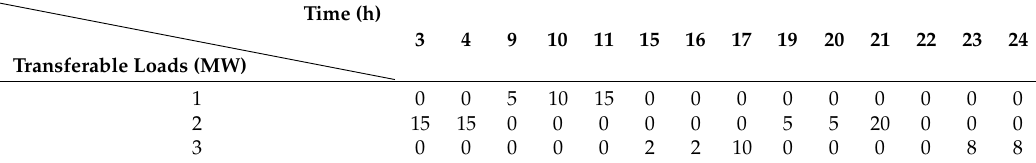
Figure 4. Load curve after dispatch. Table 4. Power consumption of transferable loads after